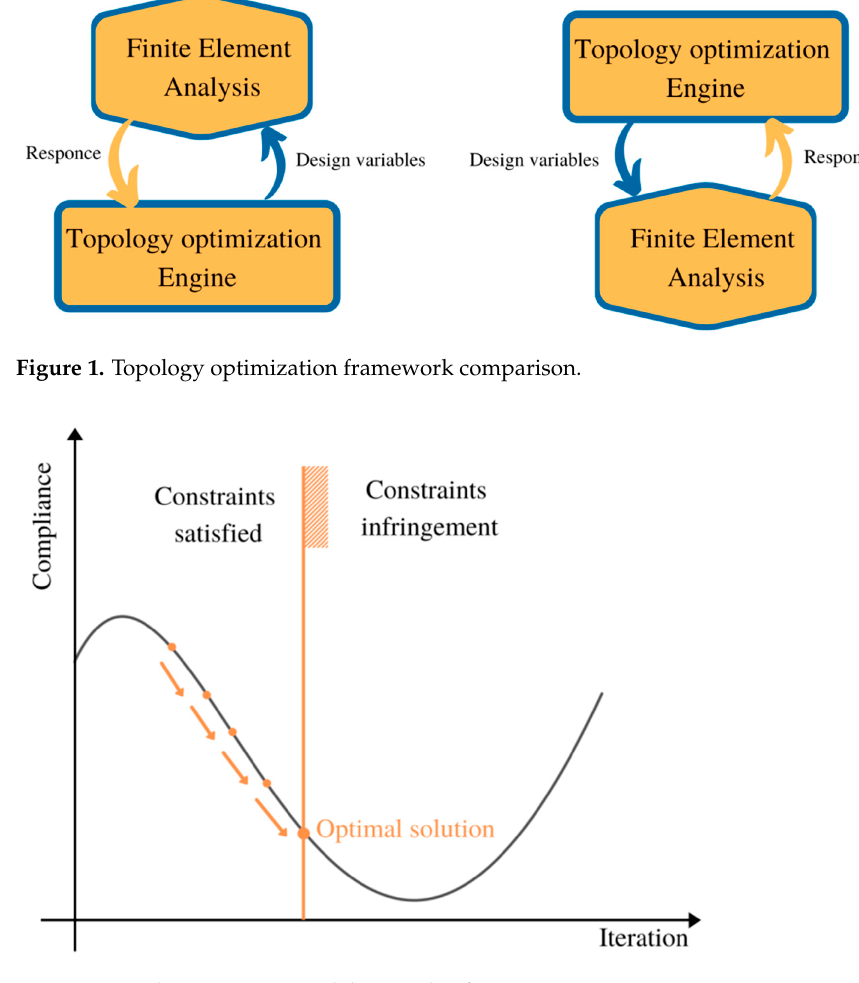
Figure 1. Topology optimization framework comparison.